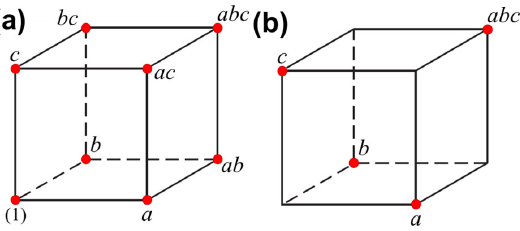
Figure 3. Geometric representation for k = 3 of the ( a ) full factorial designs and ( b ) fractional factorial designs. Adapted from Montgomery [19]. designs. Adapted from Montgomery